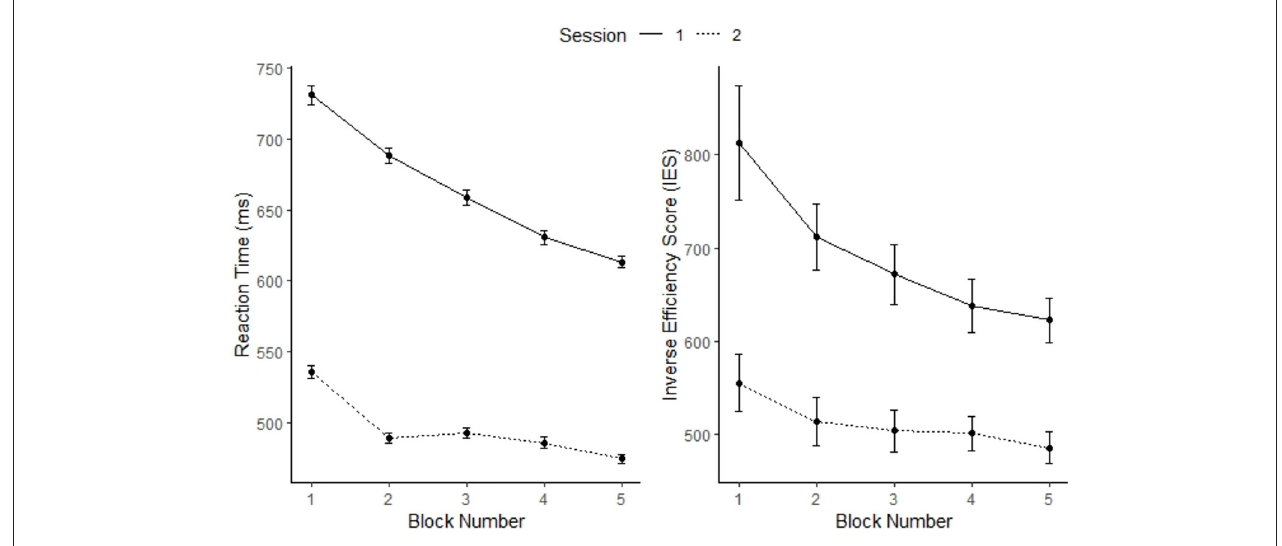
FIGURE 4 | Performance outcomes of reaction time (left) and inverse efficiency score (IES) (right) as a function of session and block. Error bars represent standard errors of the means.